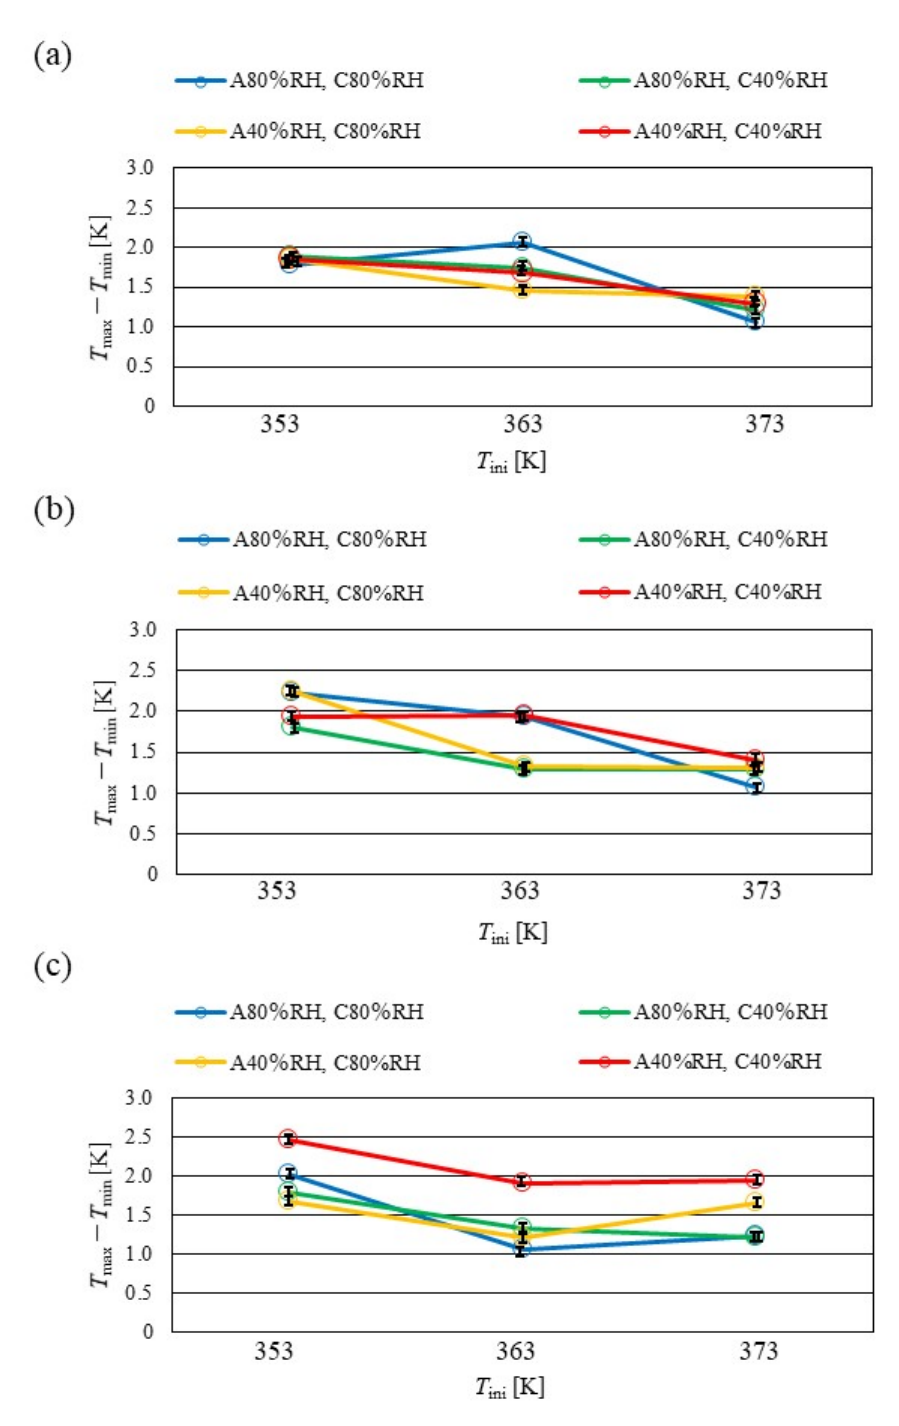
Figure 15. Comparison of relationship between T init and temperature difference T max − T min at the anode side among different RHs: ( a ) 2.0 mm; ( b ) 1.5 mm; ( c ) 1.0 mm. A80%RH&C80%RH, A80%RH&C40%RH, A40%RH&C80%RH and A40%RH&C40%RH were investigated. T max − T min decreases with the increase in T init , irrespective of the separator thickness.